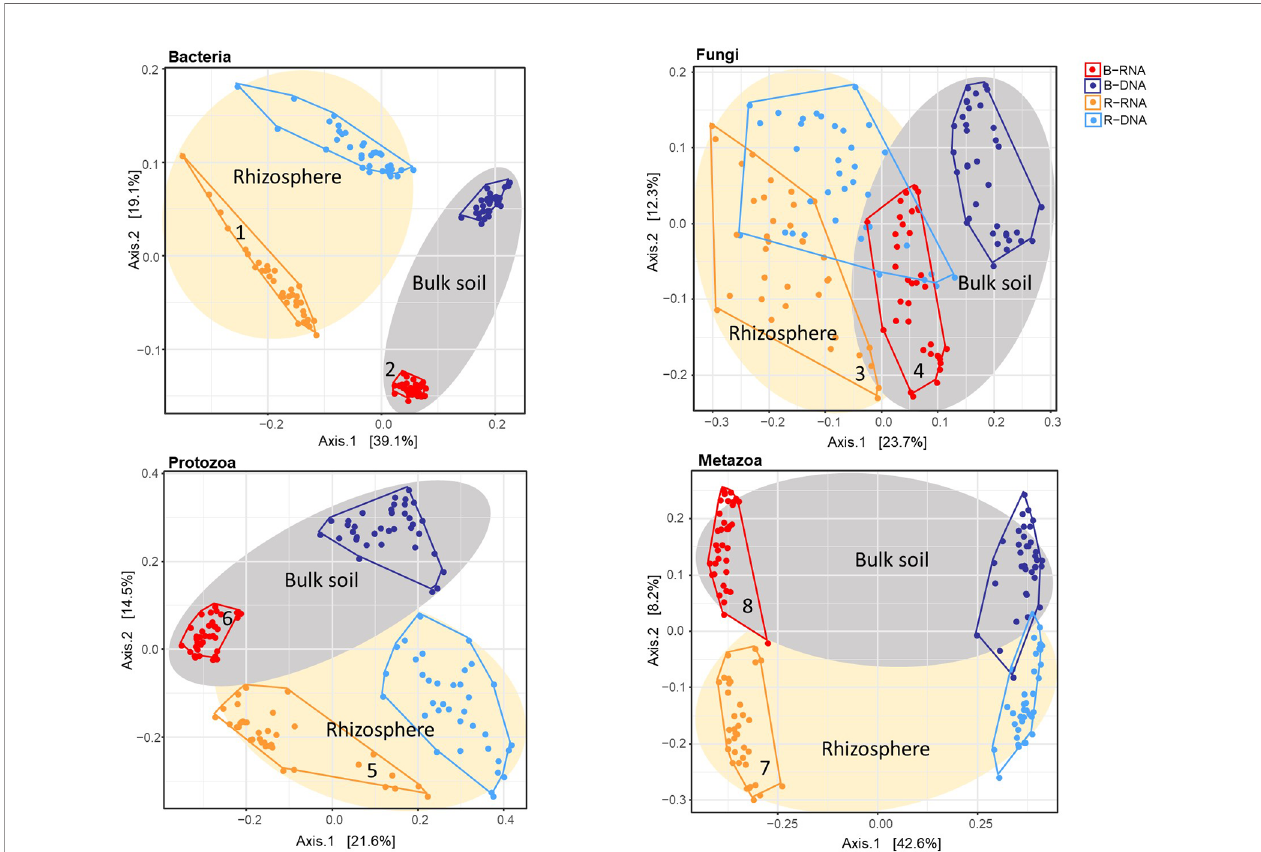
FIGURE 1 | Principal coordinate analysis (PCoA) ordination of a Bray-Curtis dissimilarity matrix. Plots illustrate distances between communities [72 soil samples; for each sample both the resident (rDNA) and the active (rRNA) community were characterized] for each organismal group: (A) Bacteria; (B) Fungi; (C) Protozoa, and (D) Metazoa. Colours were used to distinguish between rRNA-bulk (red), rRNA-rhizosphere (ochre), rDNA-bulk (dark blue), and rDNA-rhizosphere (light blue). For all organismal groups: grey ellipses for bulk and ivory ellipses for rhizosphere. Numbers accompanying the active bacterial, fungal and protozoan communities (ochre and red) correspond to the numbers in the top left or top right corner of Figure 2